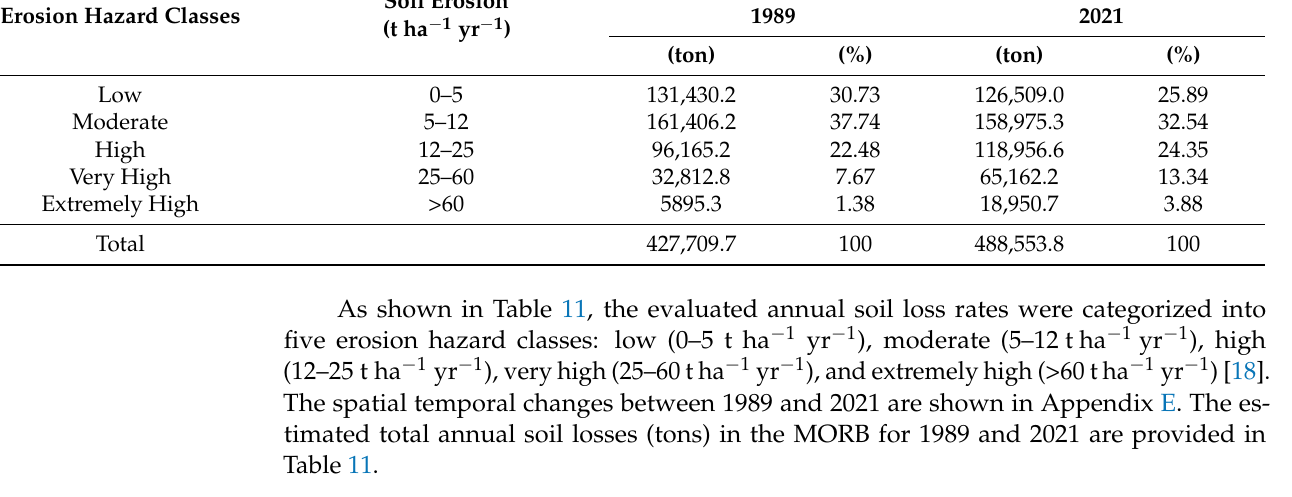
Table 11. Distribution of mean annual soil erosion under different erosion hazard classes in MORB from 1989 to